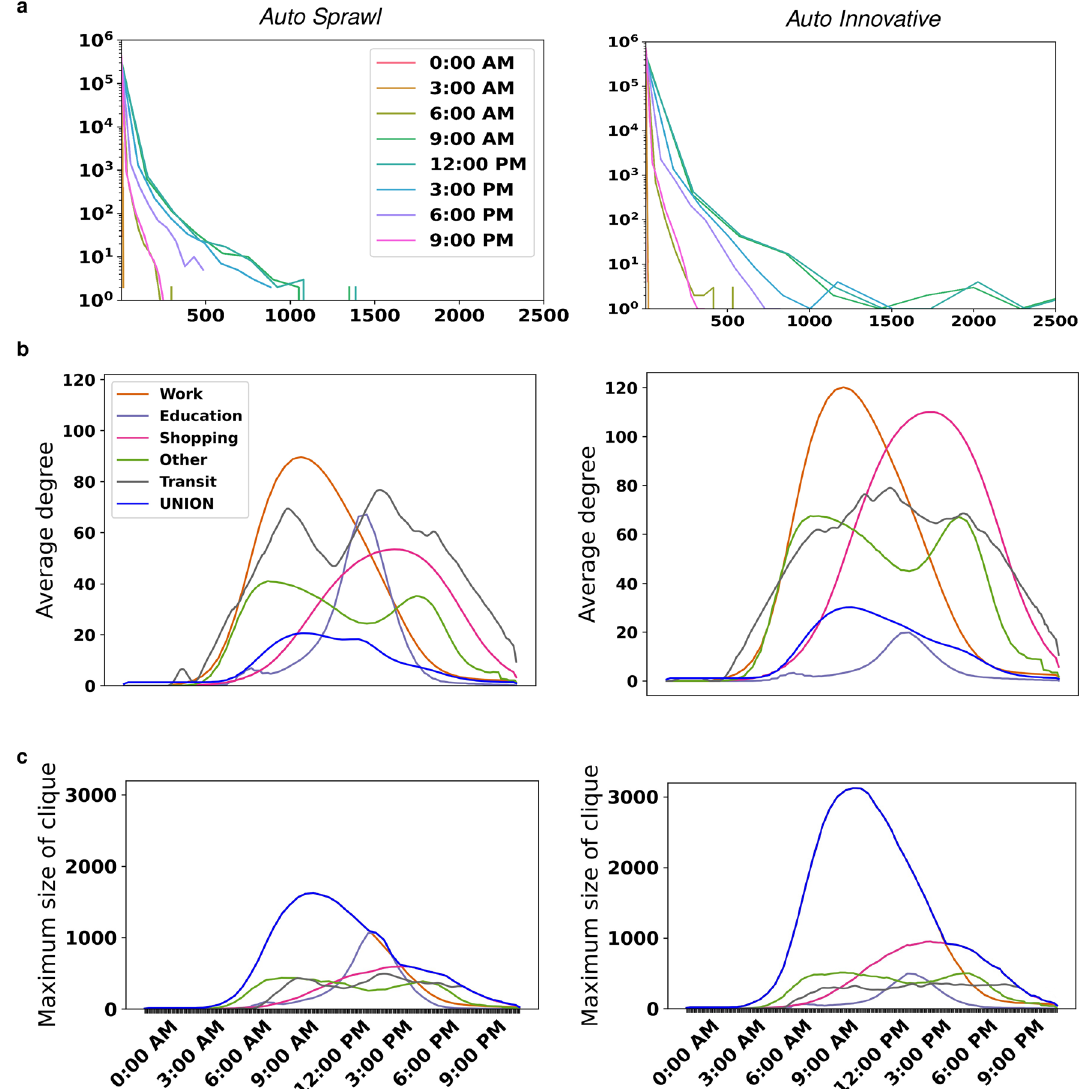
Figure 3. Contact network structure. The Union graph combines the contact networks from all activity types in a given day. ( a ) Degree distributions of the contact network ( Union graph) for selected times of day; ( b ) The average degree (cid:31) k (cid:30) for both cities are shown over the course of the day; ( c ) Diameter (maximum clique size). During work hours, the maximum clique size of the Union graph is due to the Work graph; post work hours, this is due to the Shopping graph. Plots are smoothed using a moving average of six time